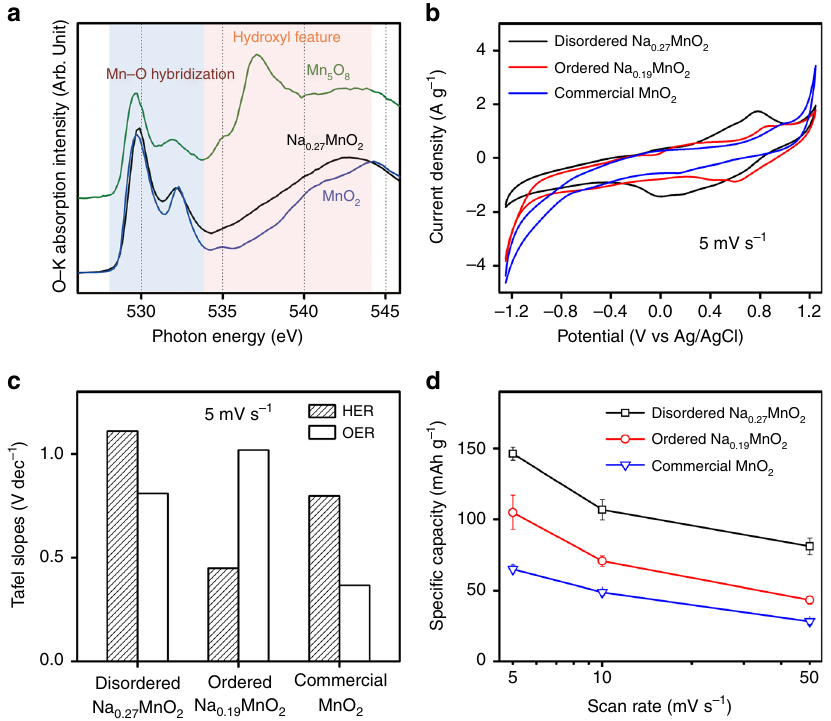
Fig. 8 The effects of disorder structure on the potential window. a Oxygen K-edge sXAS of electrochemically cycled Na 0.27 MnO 2 , Mn 5 O 8 and commercial MnO 2 materials; b CV scans of disordered Na 0.27 MnO 2 , ordered Na 0.19 MnO 2 and commercial MnO 2 materials at the scan rate of 5 mV s − 1 in a 2.5 V potential window in half-cell; c calculated Tafel slopes of HER and OER at the scan rate of 5 mV s − 1 ; d Speci fi c capacities at the scan rate of 5, 10 and 50 mV s −